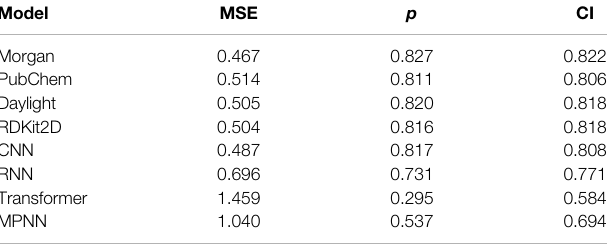
TABLE 1 | The prediction performance of the IDO1 dataset on several models. Model MSE